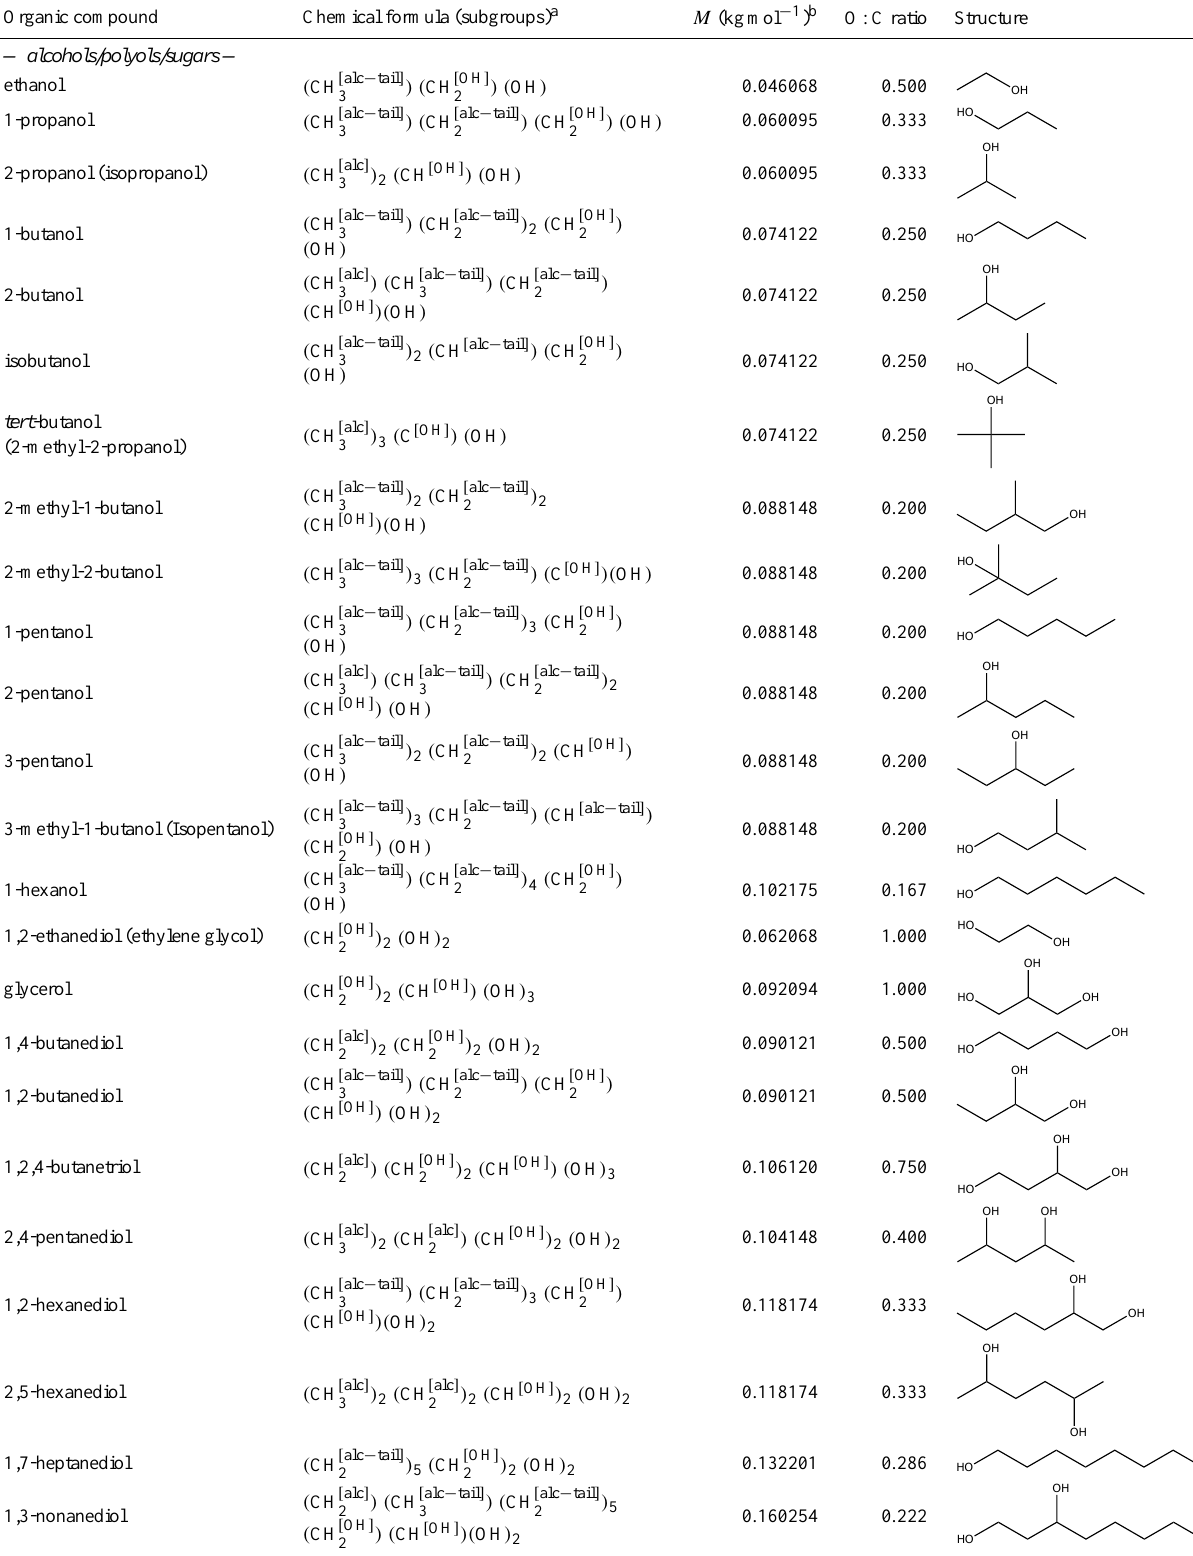
Table 3. Selected properties of organic compounds used for the middle-range parameterization of organic main group ↔ ion interactions. Organic